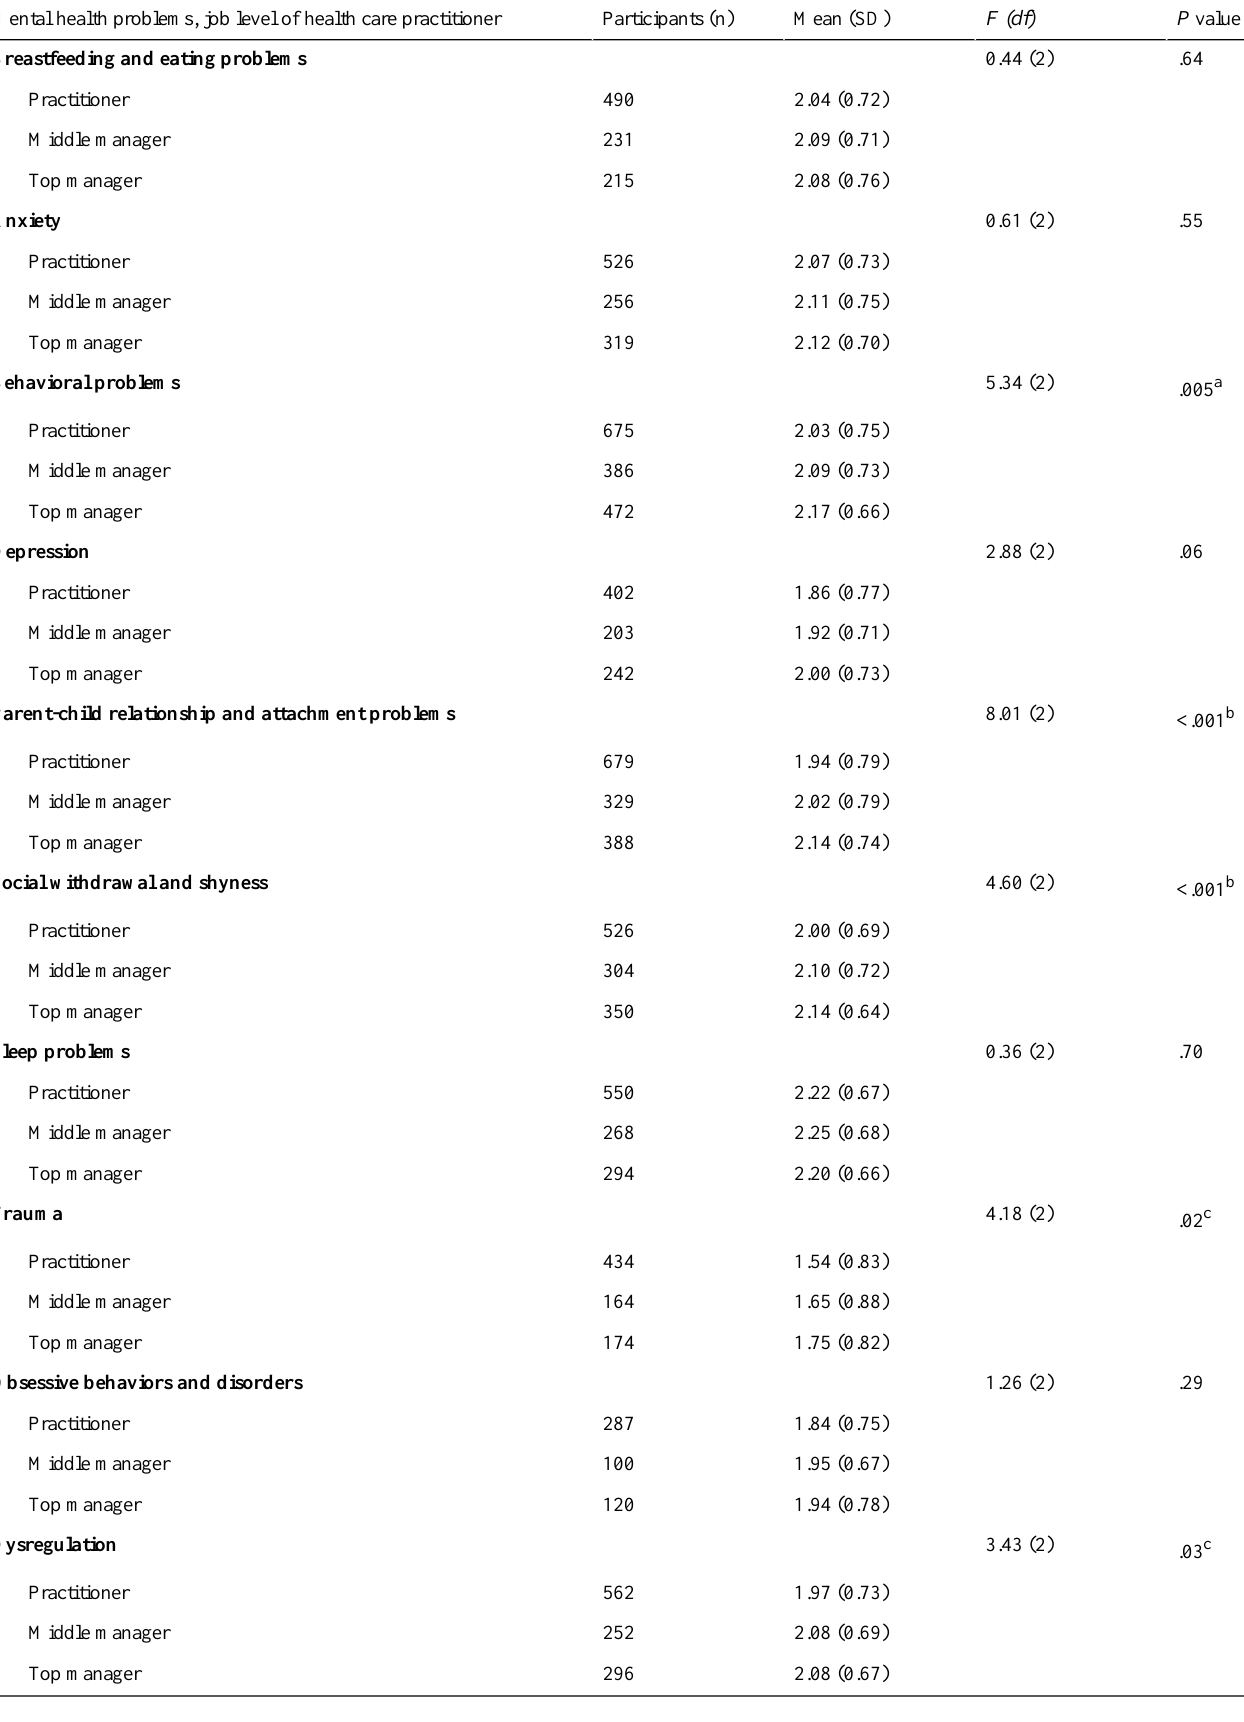
Table 3. Comparisons of the perceived usefulness of internet-based interventions for 12 different infant and child mental health problems by practitioners at different job levels (employment status) by using one-way analysis of